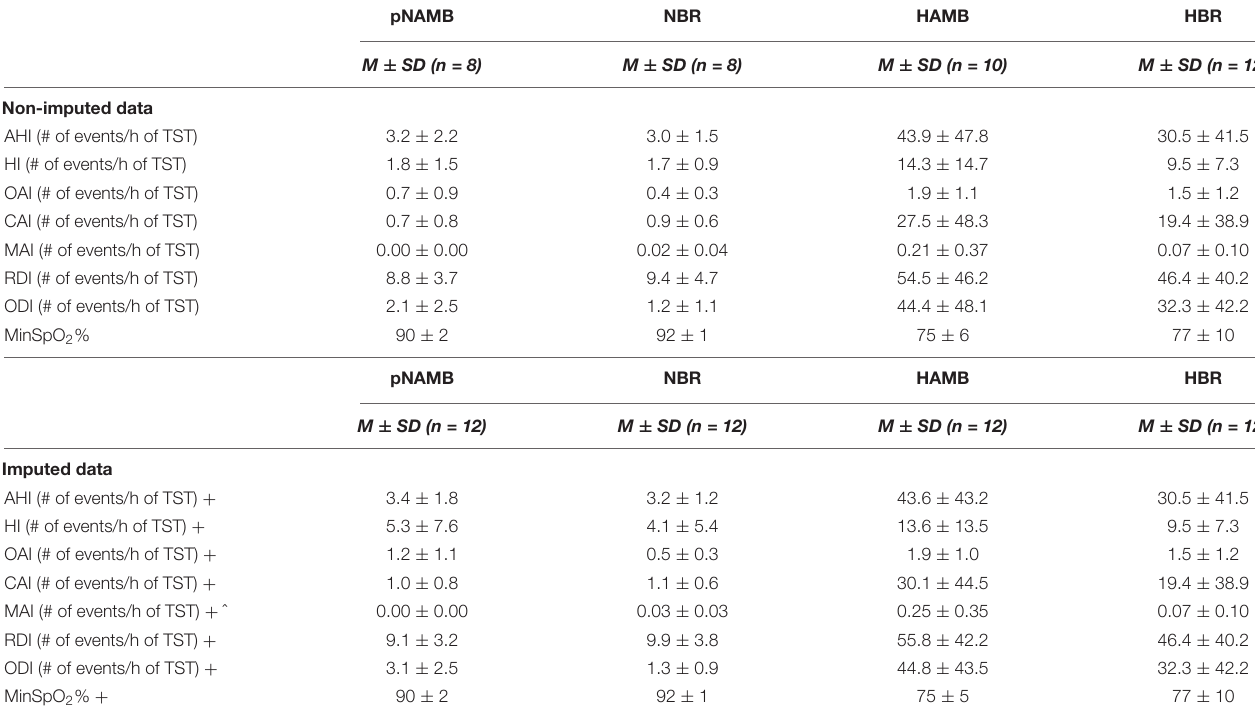
TABLE 4 | Overview of sleep-related respiration outcomes in each level of both independent variables (i.e., activity and PO 2 ). pNAMB NBR